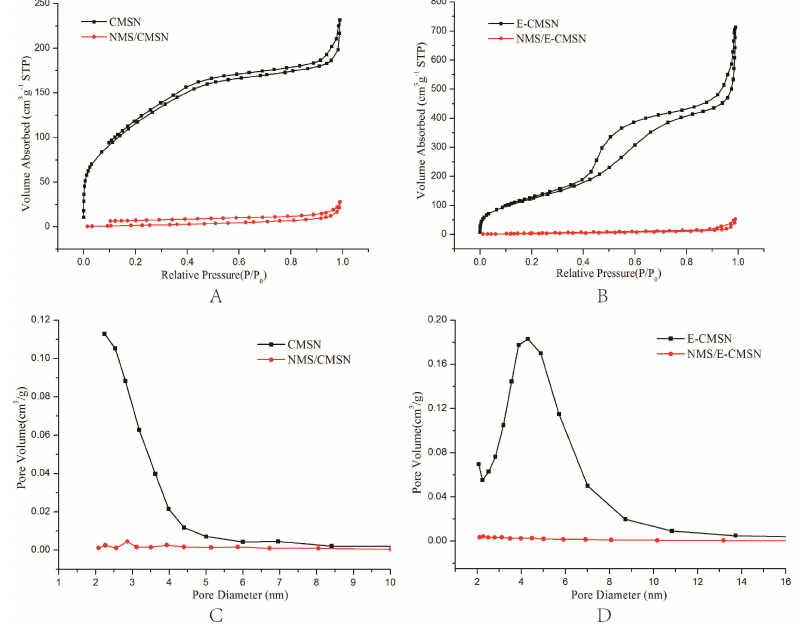
Figure 4. ( A , B ), Nitrogen adsorption / desorption isotherm of CMSN, NMS / CMSN, E-CMSN, and NMS / E-CMSN; ( C , D ), Pore size distribution of CMSN, NMS / CMSN, E-CMSN, and NMS /